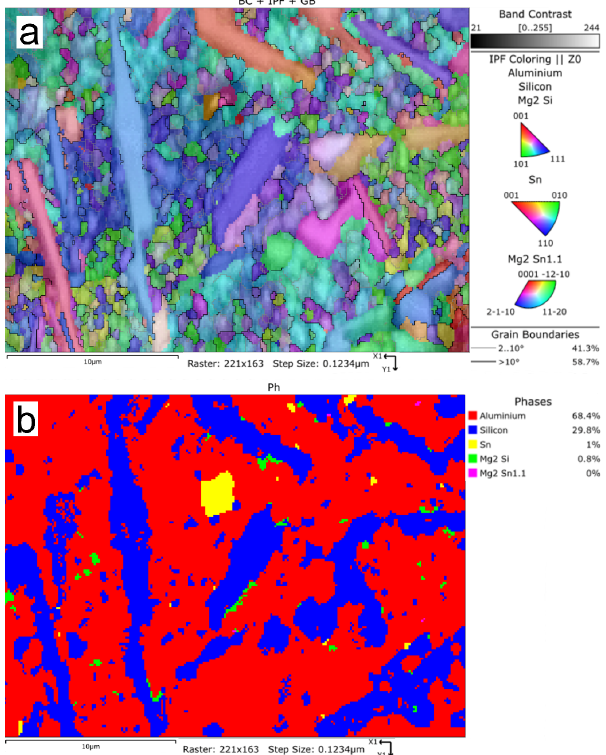
Figure 22. EBSD maps of AlSi10Sn1.7 alloy: ( a ) IPF map; ( b ) phase distribution map (red—Al; blue— Si; yellow—Sn; green—Mg2Si; pink—Mg2Sn1.1). blue—Si; yellow—Sn; green—Mg2Si;